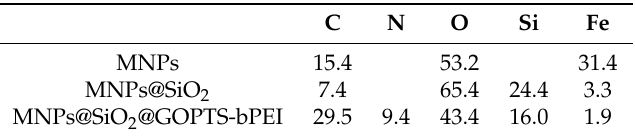
Table 1. Atomic concentrations determined with XPS for MNPs, core-shell MNPs@SiO 2 , and GOPTS-bPEI modified MNPs@SiO 2